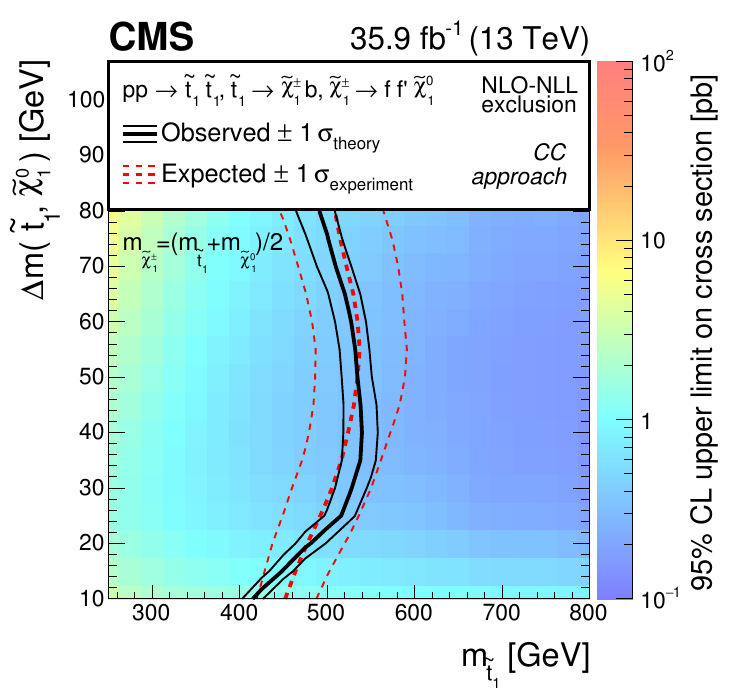
Figure 8 . Exclusion limit at 95% CL for the chargino-mediated decay of the top squark as a function of m ( t 1 ) and (cid:1) m for the CC search. The colour shading corresponds to the observed limit on the cross section. The solid black (dashed red) lines represent the observed (expected) limits, e derived using the expected top squark pair production cross section. The thick lines represent the central values and the thin lines the variations due to the theoretical (experimental)